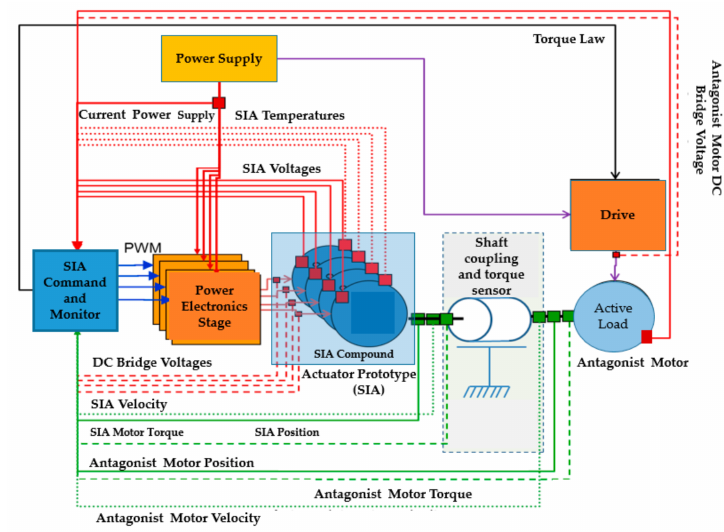
Figure A4. Overview of the bench.